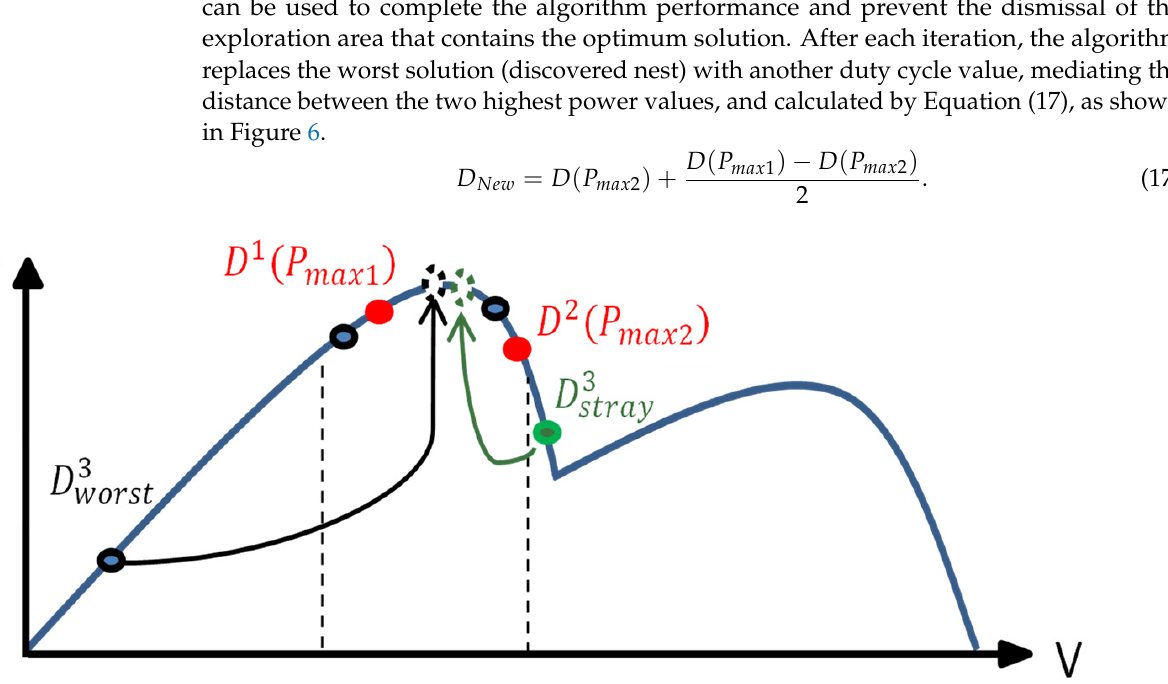
Figure 7. The flowchart of the proposed (ICSA).